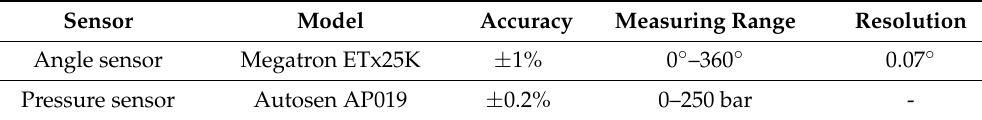
Figure 27. Experimental setup showing the exoskeleton device mounted on a test rig and connections to the data acquisition (DAQ) and control system. The inset indicates the valve block and connections to the pressure source and tank. Table 4. Specification of the sensors used in the